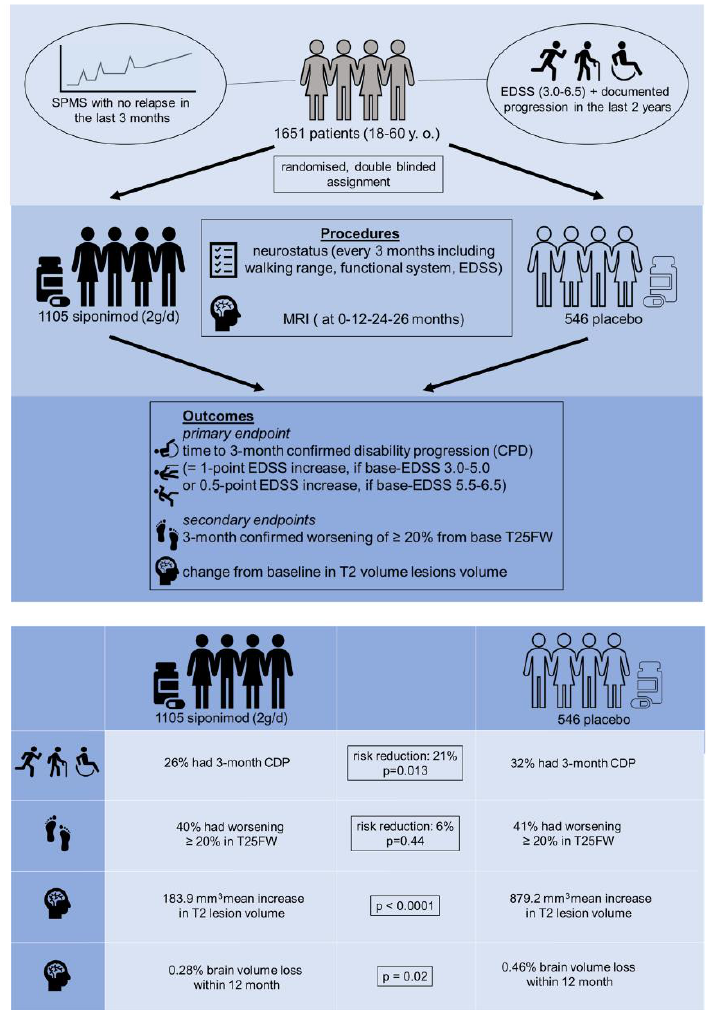
Figure 2. EXPAND-study-design: Schematic illustrating the principal design of the EXPAND trial. EDSS (Expanded Disability Status Scale); CDP (confirmed disability progression); T25W (timed 25-